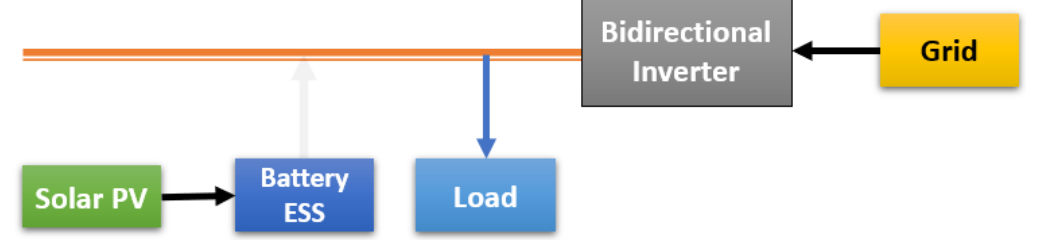
Figure 7. The optimization model during off-peak load hours.